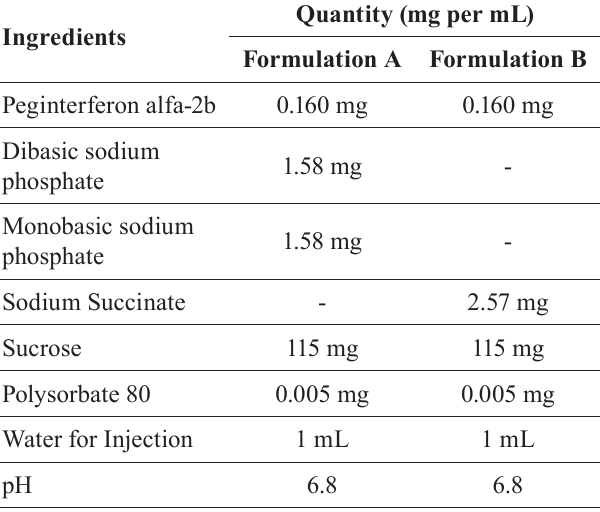
TABLE I - P eginterferon alfa-2b formulated in two different buffer